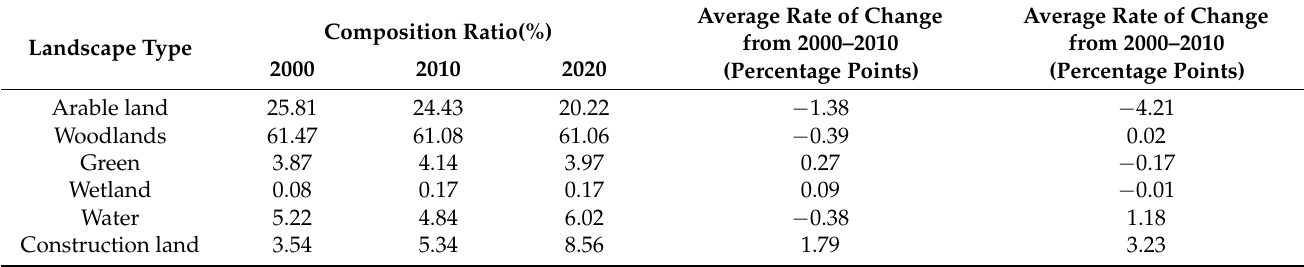
Table 2. Evolution of land use landscape composition in urban areas from 2000 to 2020.